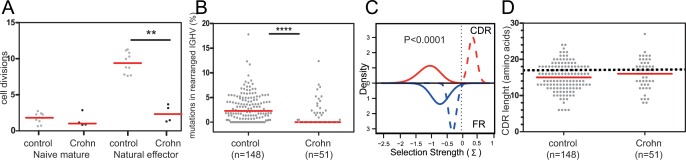
Replication history and SHM levels in IGHV genes of natural effector B cells.A, Replication history of naïve and natural effector B cells as assessed using the KREC assay [25]. B,
IGHV mutation frequencies in rearranged IGH genes of natural effector B cells in patients and controls (total numbers of sequences indicated between brackets). Grey dots represent unique sequences; red lines represent median values. C, Selection for replacement mutation in IGHV-CDR (red line) and IGHV-FR regions (blue lines) as determined with the BASELINe program [28, 29]. Solid lines represent patients; dashed lines represent healthy controls. Selection Strengths >0 indicate positive selection. D, IGH-CDR3 size distributions. All individual sizes are indicated as grey dots, red lines representing median values. The dashed line represents median values for centroblasts and centrocytes. Sorted cells were analyzed from patients 15, 16, 18 and 19. Controls were published previously [30, 31]. Statistical analysis was performed with the Mann-Whitney test; *, P<0.05; **, P<0.01; ***, P<0.001; ****, P<0.0001.